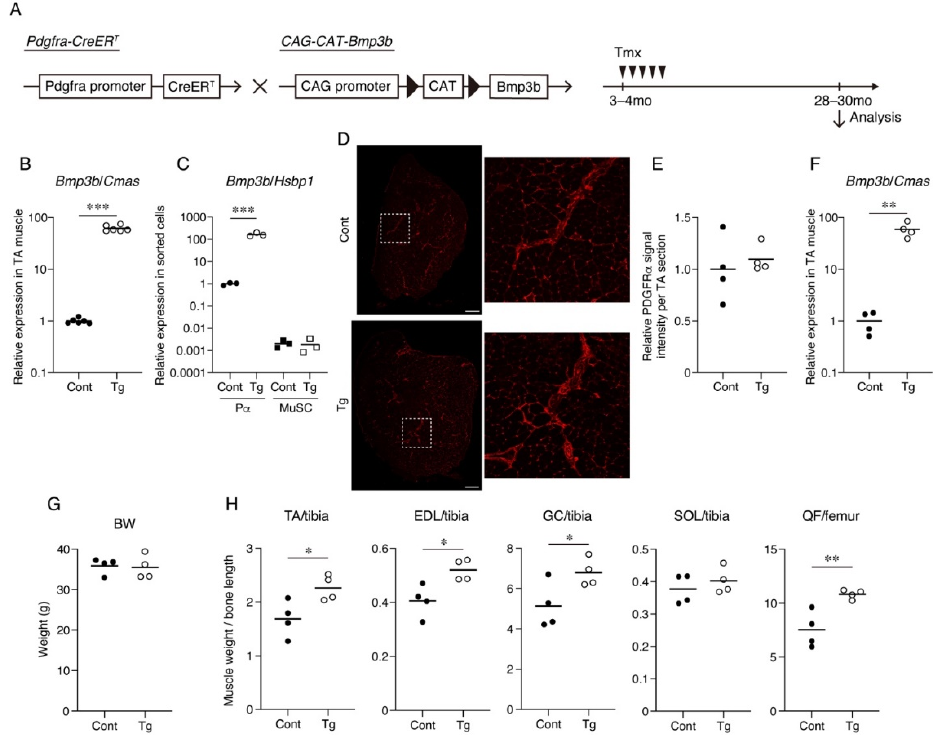
Figure 1. Mesenchymal Bmp3b Tg mice exhibit heavier muscle weights. ( A ) Mesenchymal Bmp3b Tg mice were generated by crossing Pdgfra-CreER mice and CAG-CAT-Bmp3b mice. In Pdgfra-CreER / CAG-CAT-Bmp3b mice, the administration of tamoxifen allows the translocation of CreER to the nucleus and excision of the floxed CAT gene, resulting in the expression of Bmp3b under the control of the CAG promoter specifically in Pdgfra + mesenchymal progenitors. ( B ) The expression of Bmp3b in the tibialis anterior (TA) muscle was compared between the Tg mice and littermate control mice (Cont, WT / Pdgfra-CreER , or WT / CAG-CAT-Bmp3b ). ( C ) The expression of Bmp3b in sorted PDGFR α + cells (P α ) or satellite cells (MuSC) was compared between the Tg mice and littermate control mice (Cont, WT / CAG-CAT-Bmp3b ). ( D ) TA muscle sections of the Tg mice and littermate control mice (Cont, WT / CAG-CAT-Bmp3b ) were stained with an antibody against PDGFR α (red). The right panels are magnified views of the boxed regions in the left panels. ( E ) The PDGFR α signal intensity per TA section was quantified. ( F ) The expression of Bmp3b in the TA muscle was compared between the geriatric Tg mice and geriatric littermate control mice (Cont, WT / CAG-CAT-Bmp3b ). ( G ) The body weights were comparable between the genotypes. ( H ) The TA, extensor digitorum longus (EDL), gastrocnemius (GC), soleus (SOL), and quadriceps femoris (QF) weights were measured and then normalized by the bone length. The normalized muscle weight was compared between the Tg mice and littermate control mice (Cont, WT / CAG-CAT-Bmp3b ). The data are expressed as the means and individual data points; two-sided unpaired t -test. n = 6 mice ( B ), n = 3 mice ( C ), and n = 4 mice per genotype ( E – H ). * p < 0.05, ** p < 0.01, and *** p < 0.001. Scale bar: 300 µ m ( D ).